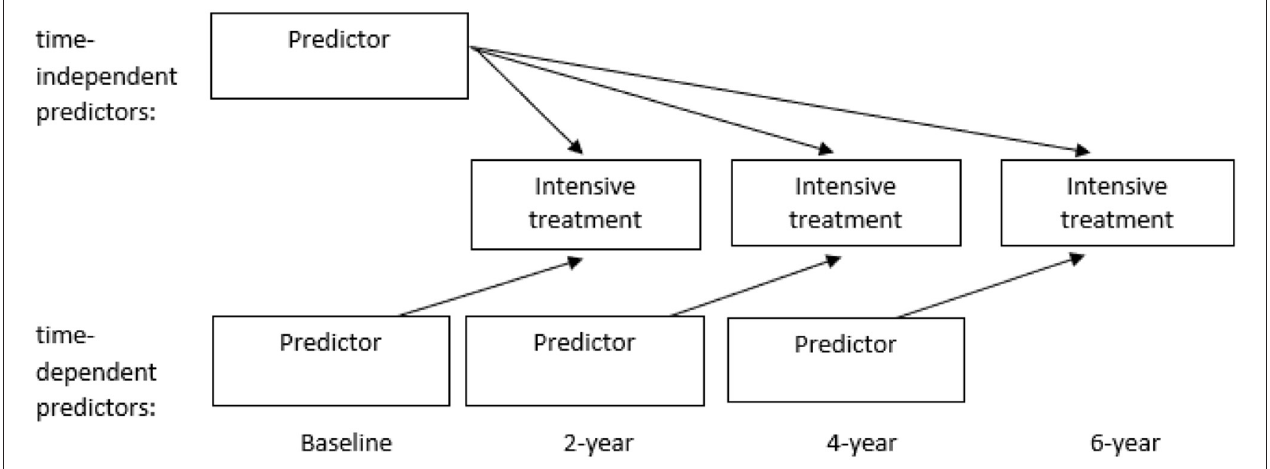
FIGURE 1 | Schematic representation of statistical analyses.